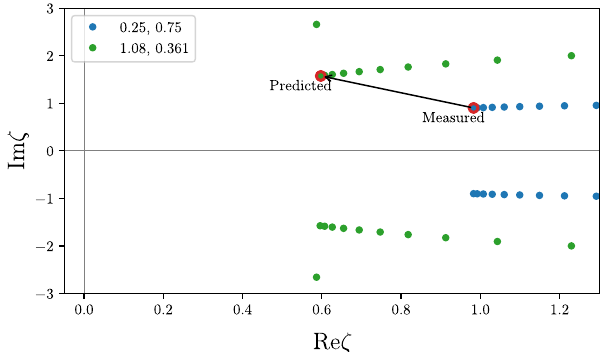
FIG. 7. Borel plane for the distribution function in RTA kinetic theory in Bjorken flow, for the 1 =w expansion. According to Eq. (102), the value of the singulant χ ð p 1 ; p 2 Þ can be predicted along a certain trajectory in the space of ð p 1 ; p 2 Þ . We verify this by calculating the singulants for two points on such a curve. These singulants are shown in the Borel plane and the two sets of parameters correspond to the blue and green points in the figure. From the singulant revealed by one set, we predict the location for the other parameters and confirm this prediction using the explicit large-order